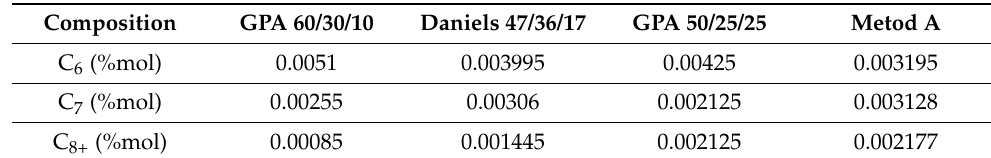
Table 5. Esenyurt RM-A station gas C 6 /C 7 /C 8 separated component